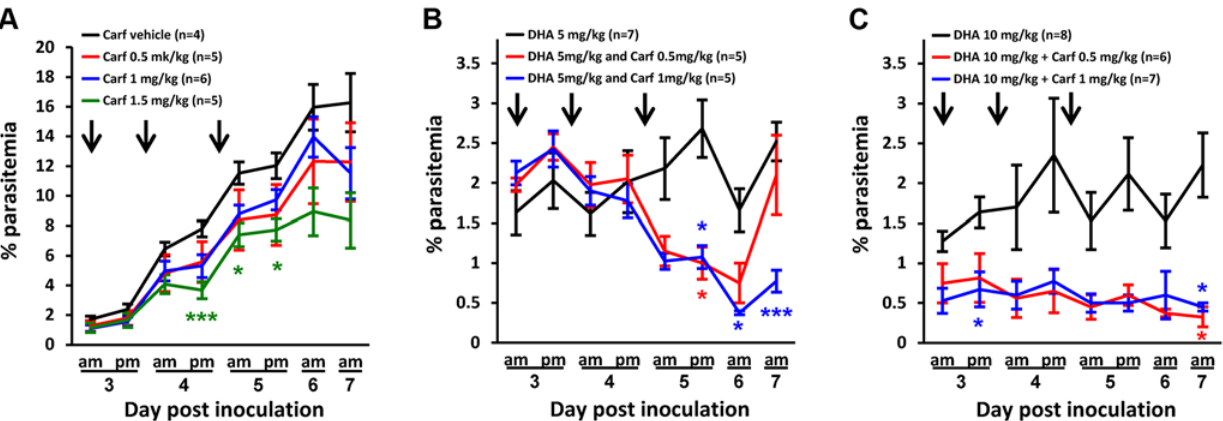
Fig 6. In vivo synergy between DHA and Carfilzomib in a P . berghei mouse model. Balb/c mice were infected with 10 6 parasites ( P . berghei ) and treatment was initiated at ~1% parasitaemia (i.e., day 3), indicated with an arrow. Data represent averages of data from three independent experiments. (A) Carfilzomib alone has no effect on parasite growth at doses of 0.5 and 1 mg/kg, but has a slight antimalarial effect at 1.5 mg/kg. (B) Treatment with DHA (5 mg/kg) + Carfilzomib (0.5 mg/kg) reduces parasite growth, while DHA (5 mg/kg) + Carfilzomib (1 mg/kg) prevents parasite growth. (C) DHA (10 mg/kg) + Carfilzomib (0.5 or 1 mg/kg) also reduces parasitemia by 2- to 3-fold. Error bars represent SEM and * and *** represent, respectively, p < 0.05 and p < 0.01, after Bonferroni correction for multiple testing.